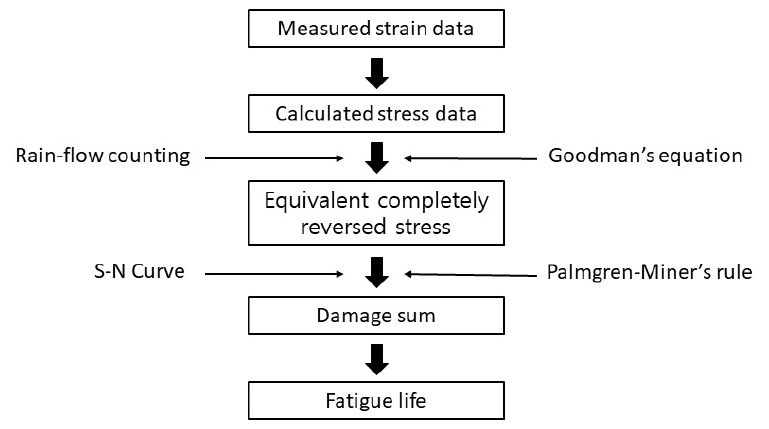
Figure 9. The procedure of fatigue life calculation for the transplanting device.